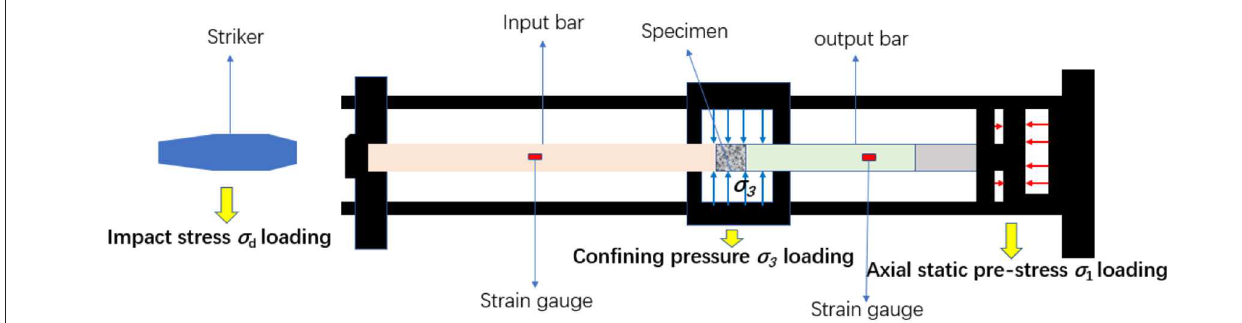
FIGURE 3 | Schematic of the SHPB experimental system.